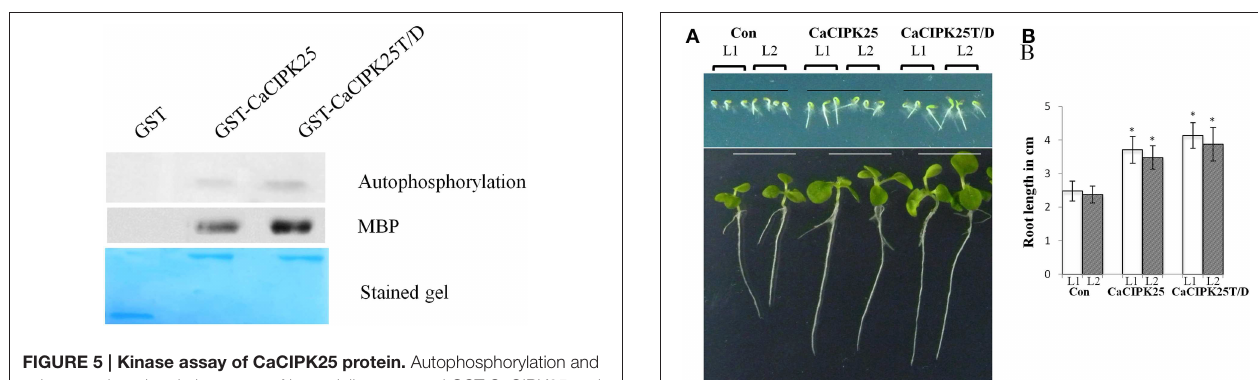
FIGURE 5 | Kinase assay of CaCIPK25 protein. Autophosphorylation and substrate phosphorylation assay of bacterially expressed GST-CaCIPK25 and CaCIPK25T/D proteins. GST protein was used as control. Myelin basic protein (MBP) was used as substrate. A Coomassie blue-stained gel shows the amount of CaCIPK25 protein loaded.